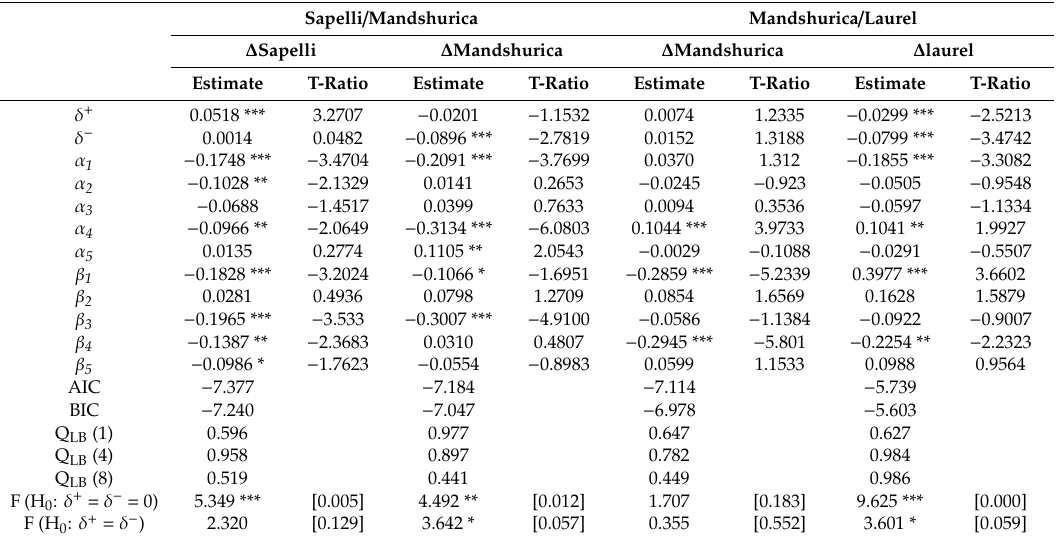
Table 8. Results of the threshold error correction model for the second